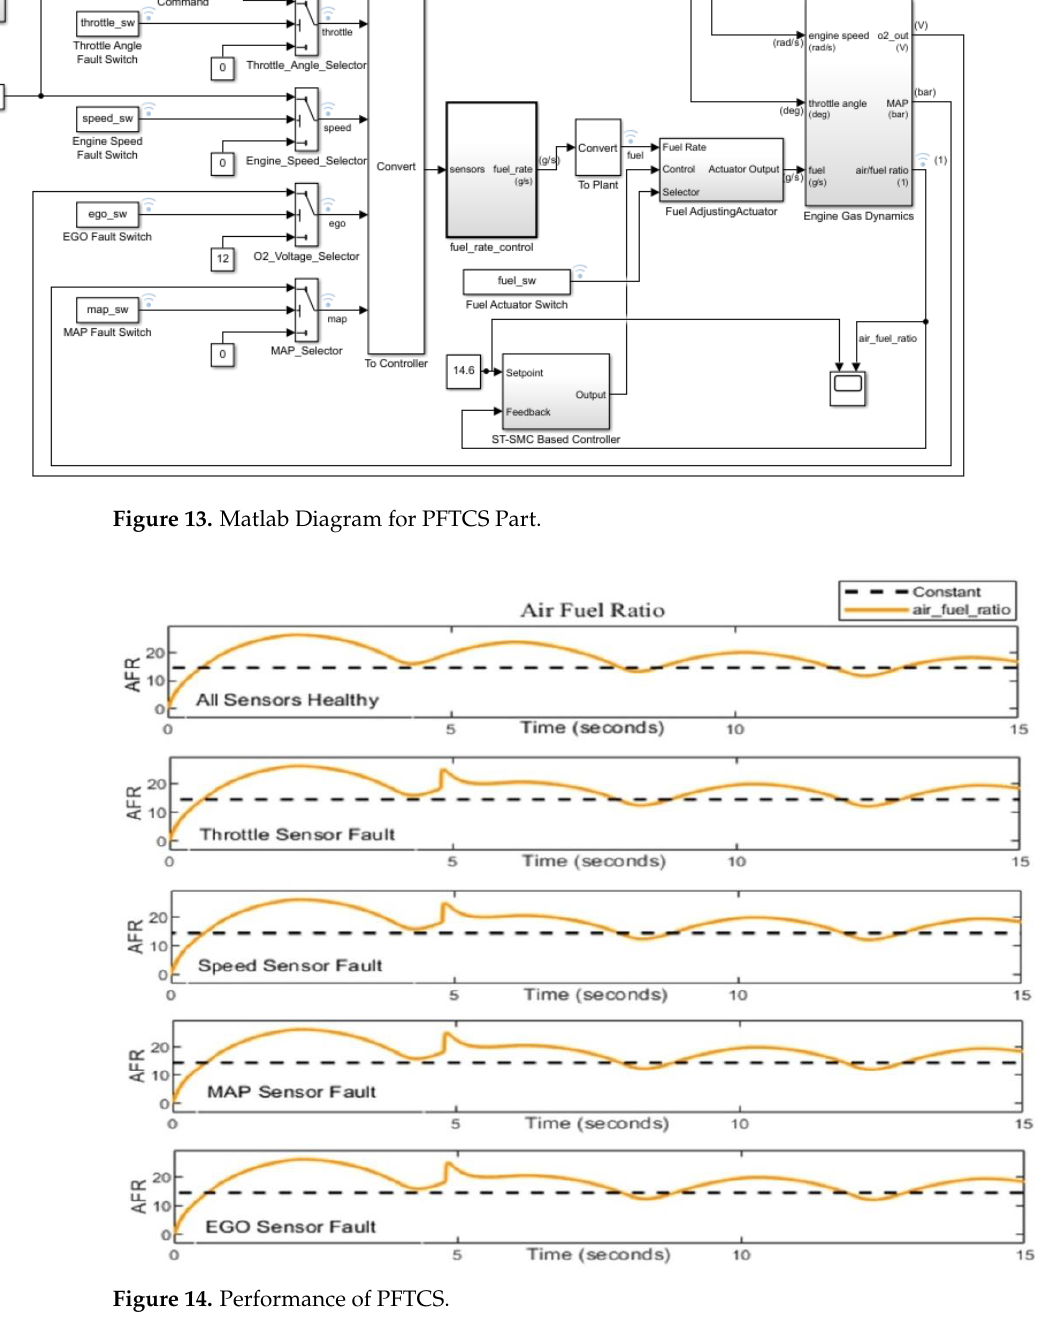
Figure 14. Performance of PFTCS.